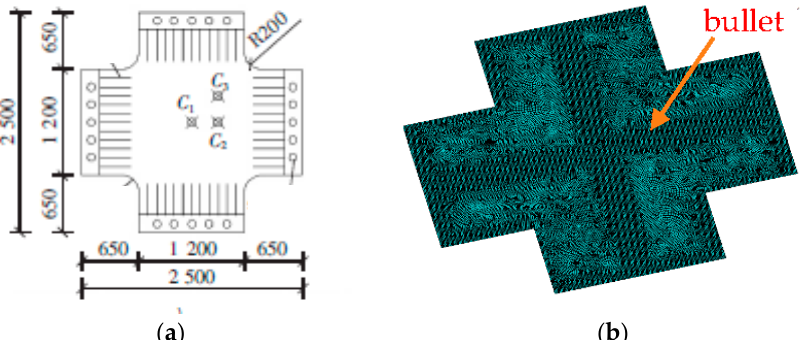
Figure 5. The experiment model and the numerical model. ( a ) Experiment geometry model (mm). ( b ) Numerical model with hiding air element.